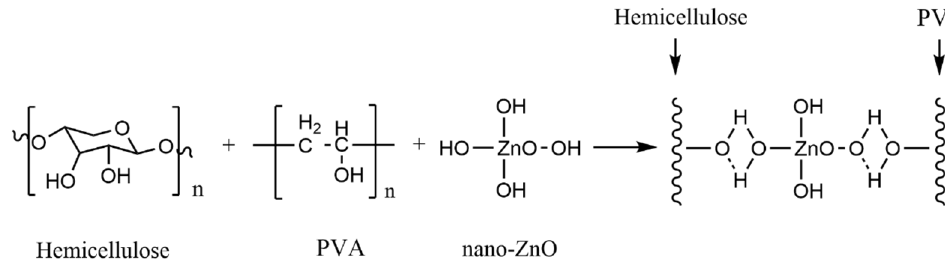
Figure 7. Hydrogen bond interaction between nano-ZnO particles and PVA/xylan composite film.